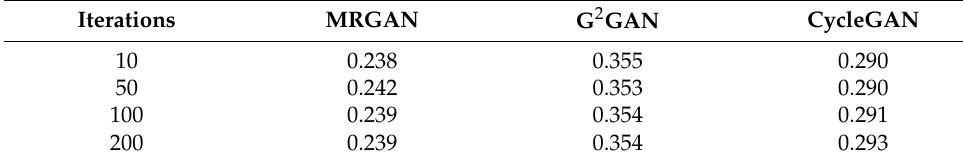
Table 2. Average time consumption under different number of generated images (s).